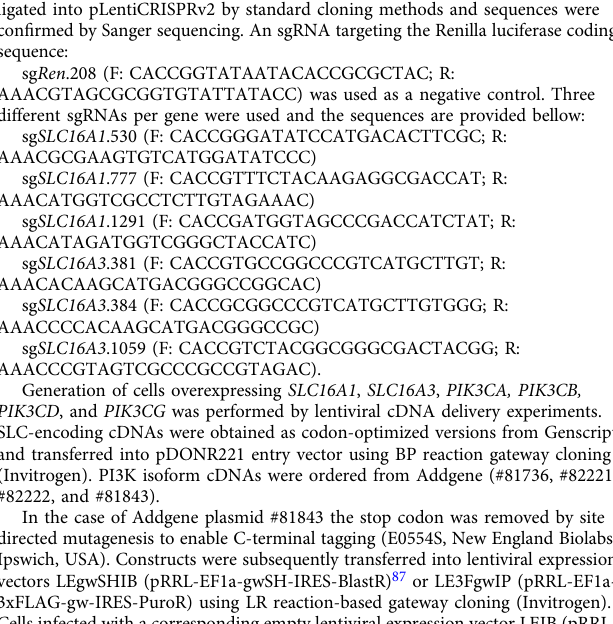
Fig. 9 Metabolic drug sensitivity pro fi les are generally comparable between myeloid cancer patient samples and cell lines. a A volcano plot depicting the comparison of 70 drug responses between 15 myeloid cancer patient samples and 15 myeloid cancer cell lines. Each point represents one drug and statistical signi fi cance was assessed by Mann – Whitney test for each drug. The log2 AUC (fold change) is plotted on the x-axis and negative log10 of the adjusted P values (using the two-stage step-up Benjamini, Krieger, and Yekutieli correction) is plotted on the y -axis. The horizontal dotted line signi fi es the 5% signi fi cance cutoff. Colored dots indicate drugs that exhibit higher sensitivity in either patient samples (red) or cell lines (blue). b Spearman correlation of drug response pro fi les between myeloid leukemia patient samples and cell lines. Drugs that were highlighted to strongly contribute to the cell line grouping are marked in green. c Heatmap of metabolic drug sensitivity pro fi les expressed as AUC in 12 AML and 3 CML patient samples. Clustering was performed with the complete linkage method and Spearman (drugs) and Euclidean (patient samples) distance measures. The color bars to the left and above show sample annotations with gray box depicting data not available and white box depicting no mutation detected. Drug AUC distribution (min